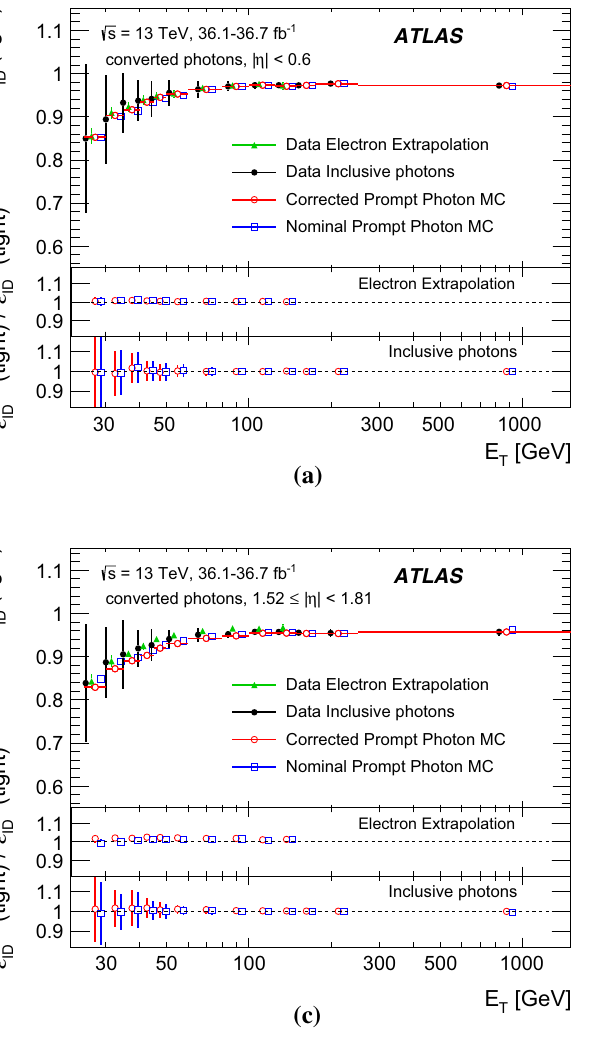
and d 1 . 81 ≤ | η | < 2 . 37. Predictions are shown for both the nominal simulation and with the corrections described in Sect. 4.1. The bottom panels show the ratio of the data-driven values to the MC predictions (referred to as scale factors in the text). The last bin extends to 1.5